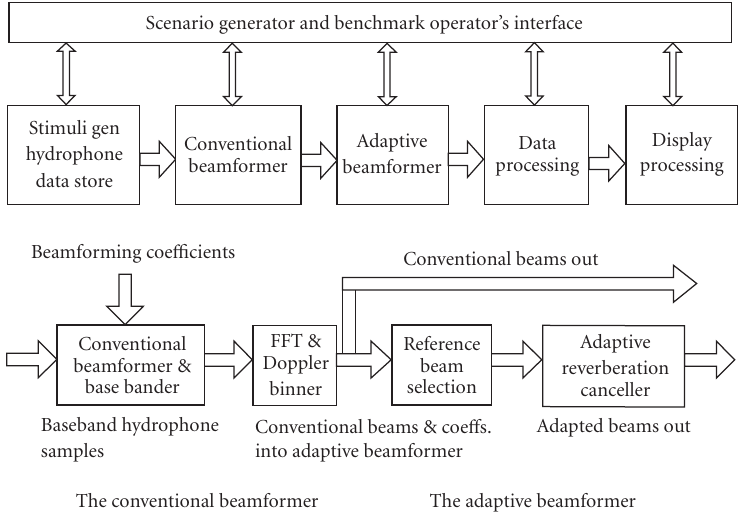
Figure 7: Sonar functional processing chains.